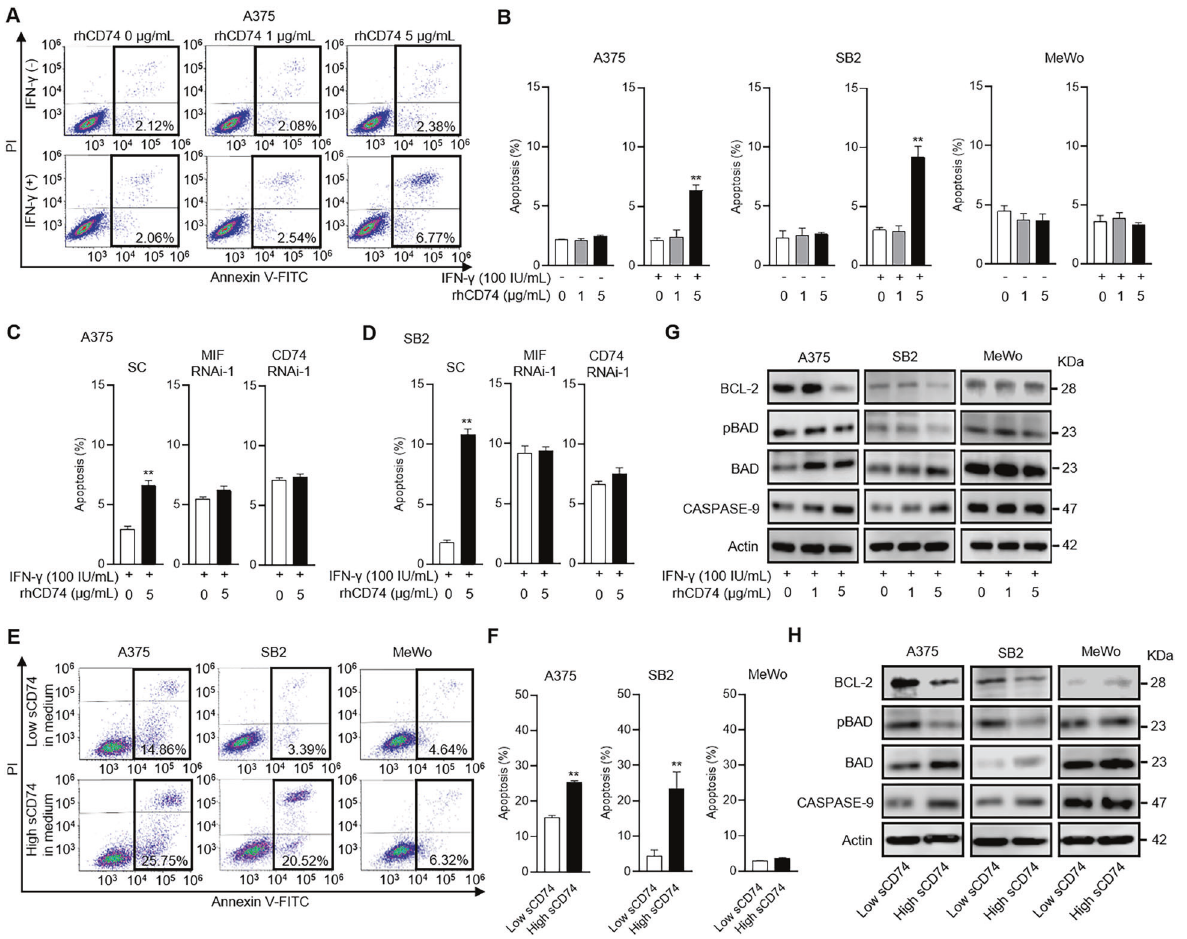
Fig. 5 sCD74 exerts pro-apoptotic functions by inhibiting MIF – CD74 interaction. A Representative fl ow-cytometry plots show annexin V – FITC ( x axis) and PI ( y axis) in A375. B The rate of apoptotic cells in A375, SB2, and MeWo quanti fi ed by fl ow cytometry ( n = 3). C , D The rate of apoptotic cells in A375 ( C ) and SB2 ( D ) transfected with SC siRNA, MIF RNAi-1, or CD74 RNAi-1 quanti fi ed by fl ow cytometry ( n = 3). Flow cytometry ( A – D ) was performed 72 h after the administration of 0 or 5 µg/mL rhCD74 under 100 IU/mL IFN- γ stimulation. E Representative fl ow-cytometry plots show annexin V – FITC ( x axis) and PI ( y axis) in A375, SB2, and MeWo. F Rate of apoptotic cells in A375, SB2, and MeWo ( n = 3). Flow cytometry ( E , F ) was performed 48 h after coculture with THP-1 M Φ . High and low concentrations of sCD74 in medium were obtained by transfecting SC siRNA or CD74 RNAi-1 to THP-1 M Φ , respectively, in the presence of 100 U/mL IFN- γ . G WB analysis of BCL-2, pBAD, BAD, and CASPASE-9 in A375, SB2, and MeWo 72 h after treatment with different concentrations of rhCD74 (0, 1, and 5 µg/mL) under 100 IU/mL IFN- γ stimulation. Actin and BAD were used as loading controls. H WB analysis of BCL-2, pBAD, BAD, and CASPASE-9 in A375, SB2, and MeWo 48 h after coculture with THP-1 M Φ . Actin and BAD were used as loading controls. Graph values represent mean ± SD. Signi fi